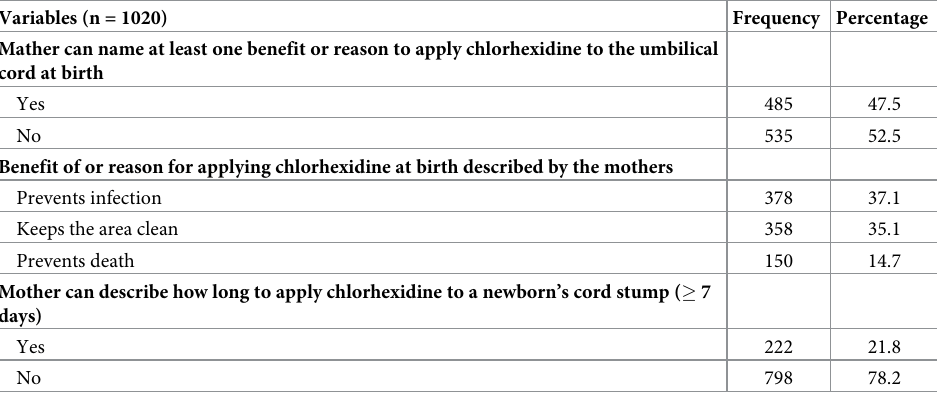
Table 2. Mothers’ knowledge of chlorhexidine cord care, four regions of Ethiopia, Feb 2020.